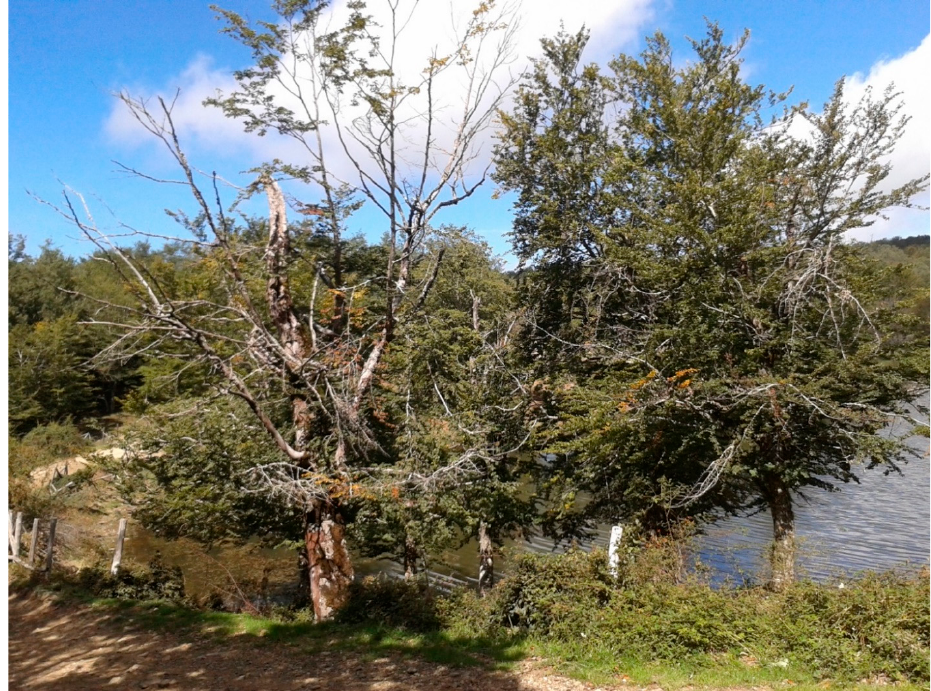
Figure 3. Severely declining trees of European beech ( Fagus sylvatica ) on the shore of Maulazzo Lake in the Nebrodi Regional Park (Sicily, southern Italy).